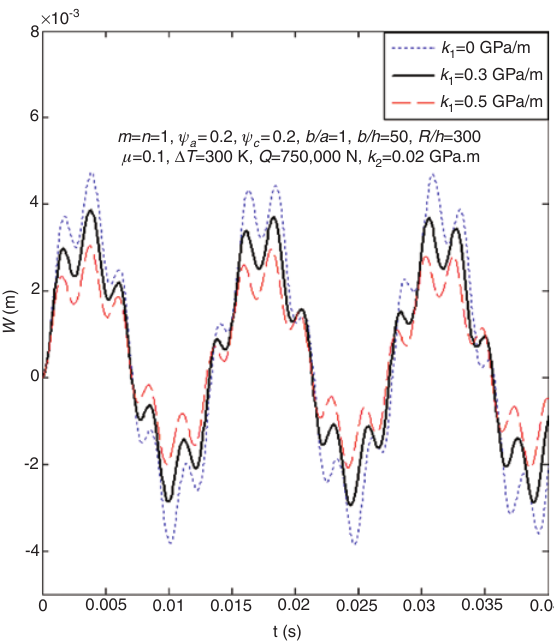
Figure 7: Effect of the linear Winkler foundation on the non-linear dynamic response of the polymer composite cylindrical panel.